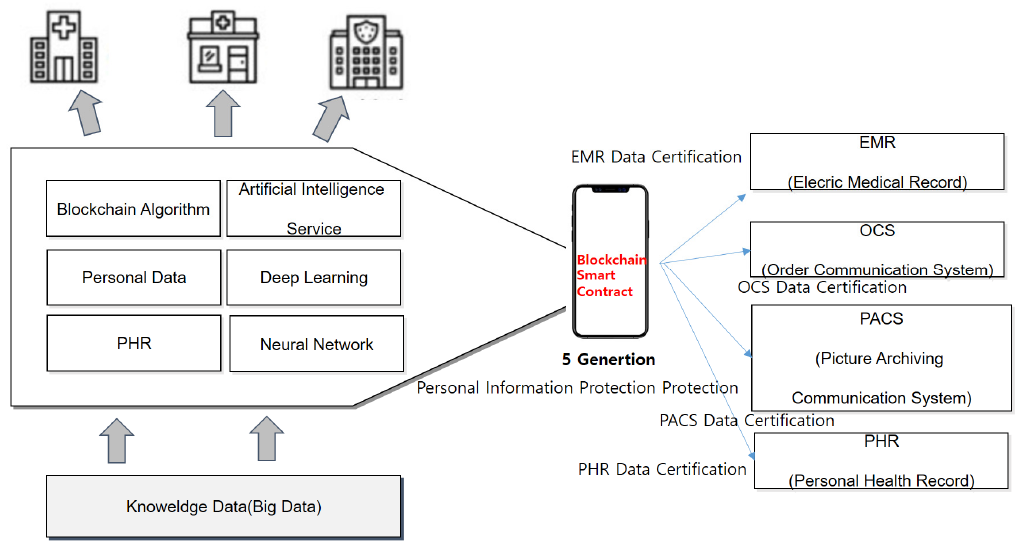
Figure 1. Healthcare verification concepts with blockchain and artificial intelligence.